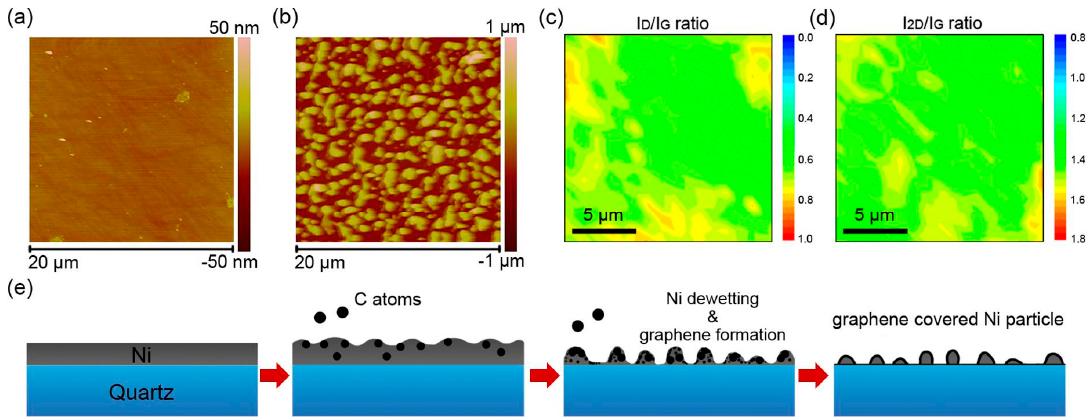
Figure 3. ( a,b ) Atomic force microscope (AFM) images of the surface morphology of as-deposited Ni layer and after Ni / G electrodes. ( c , d ) Raman mapping of I d / I G ratio and I 2D / I G ratio of ( b ). ( e ) layer and after Ni/G electrodes. ( c,d ) Raman mapping of I D /I G ratio and I 2D /I G ratio of ( b ). ( e ) Scheme of change of surface morphology and graphene fabrication during the plasma-enhanced chemical vapor deposition (PECVD) process.